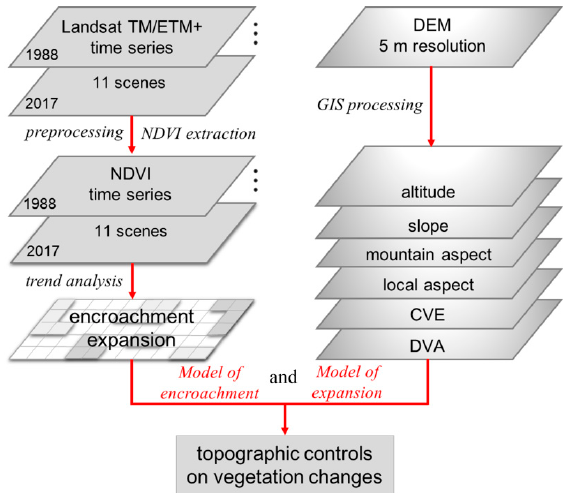
Figure 2. Flow diagram illustrating quantification of topographic controls on vegetation changes. CVE represents the coefficient of variation in elevation, DVA represents the distance to the nearest volcanic ash deposit. DEM = digital elevation model. NDVI = normalized difference vegetation index. TM/ETM+ = Thematic Mapper/Enhanced Thematic Mapper Plus.